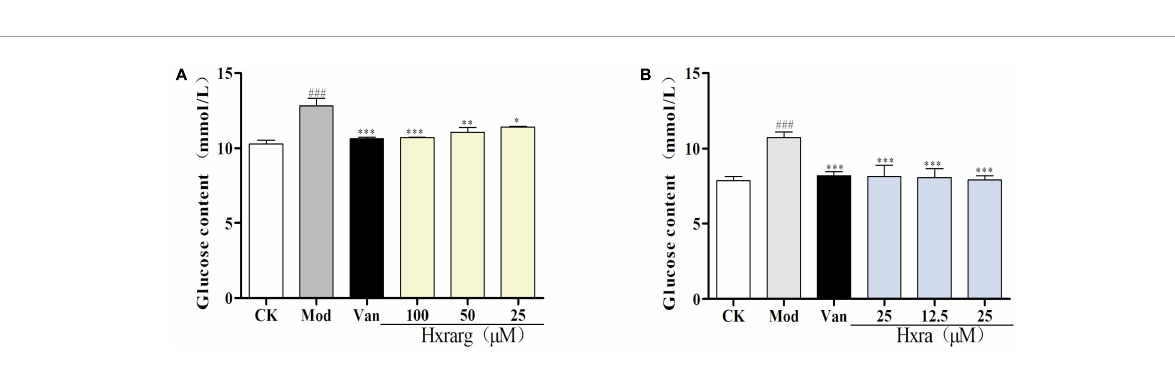
FIGURE7 Glucose uptake effect of Hxrarg (A) and Hxra (B) on IR-3T3-L1 adipocytes. Compared with control group, ### P < 0.001; compared with model group, ∗ P < 0.05, ∗∗∗ P <